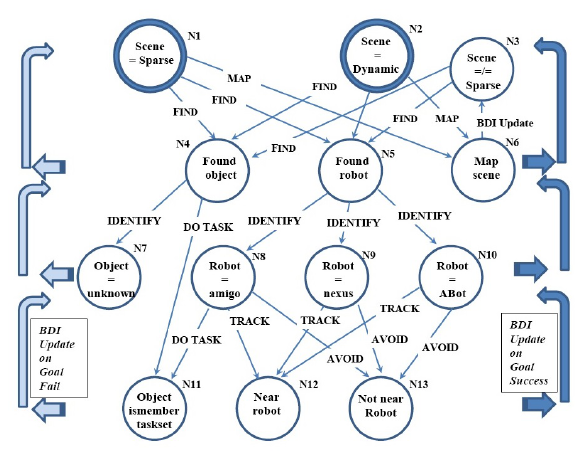
Figure 2: Example (simplified) SCARAB BDI Graph, showing alternative decision paths from two starting Belief positions (Double Circles N1 and N2) over four levels of the BDI model. Belief states shown in circles; Goal-Intention combinations as labelled arcs between Belief states. Arrows to left and right infer BDI revision upon earlier Belief states dependent upon Goal-Intention success or